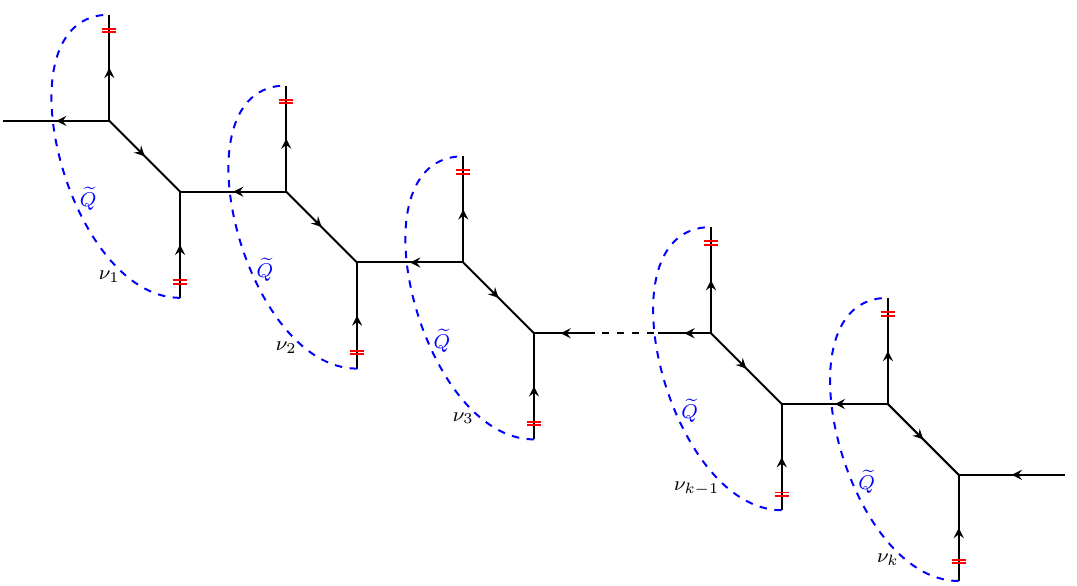
× T 2 . The preferred direction 1 ,ǫ 2 Q . This is the same strip e